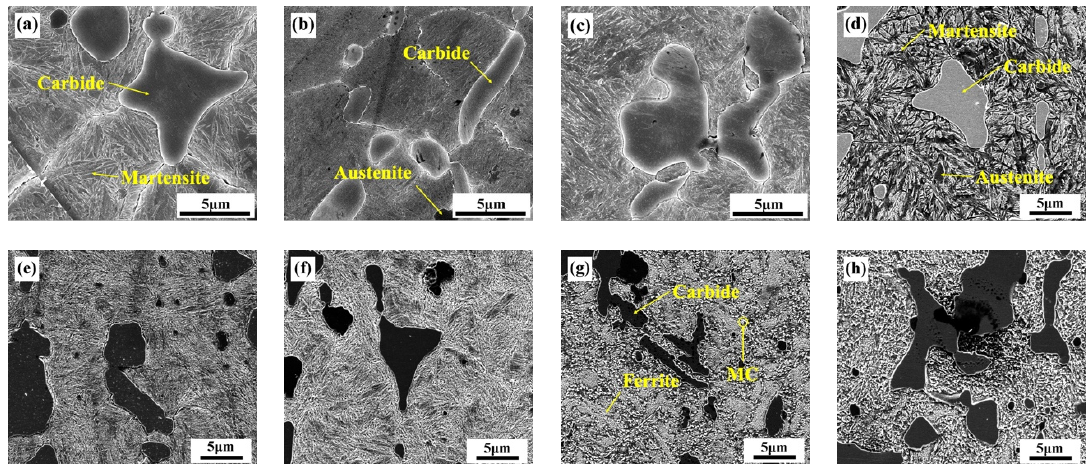
Figure 1. FESEM Micrograph of M42 HSS under Different Tempering Temperatures: ( a ) 200 °C, ( b ) 300 °C, ( c ) 400 °C, ( d ) 500 °C, ( e ) 550 °C, ( f ) 600 °C, ( g ) 650 °C, ( h ) 700 °C.